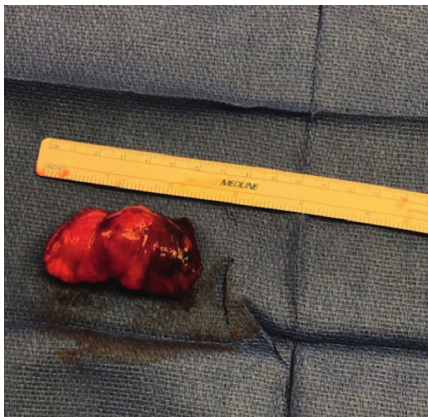
Figure 4: Surgical specimen from laparoscopic-assisted small bowel resection of the tattooed site (Figure 3).